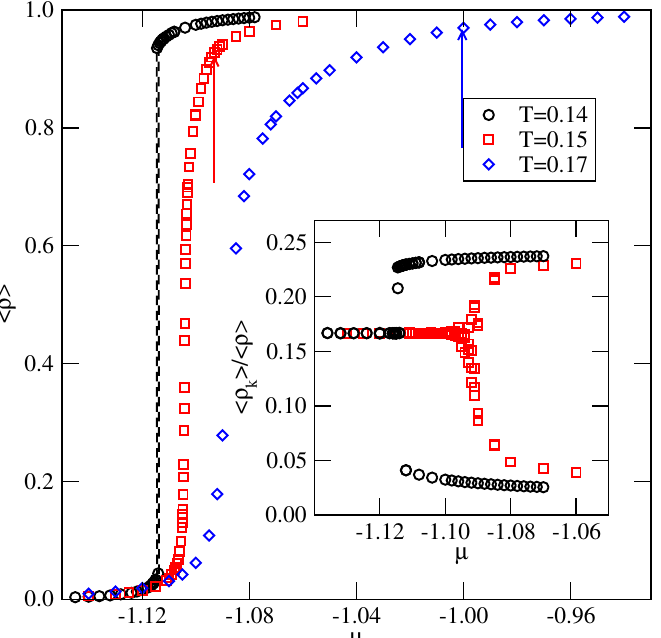
Figure 6. The main part shows the isotherms recorded at different temperatures for the system with u ∗ = − 0.05, while the inset presents the changes of the ratio (cid:104) ρ k (cid:105) / (cid:104) ρ (cid:105) along the isotherms at T = 0.14 and 0.15. The arrows in the main part mark the locations of the orientational order − disorder